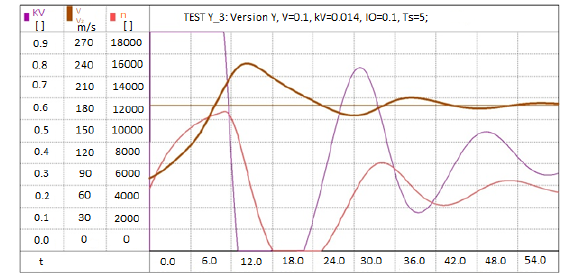
Figure 10. The transitional process of controlling flight speed V , with preset step changes to the velocity V z from 100 to 200 m/s. Testing the influence of the coefficient of reinforcement k V = 0,014. The constant of integration I 0 = 0.1